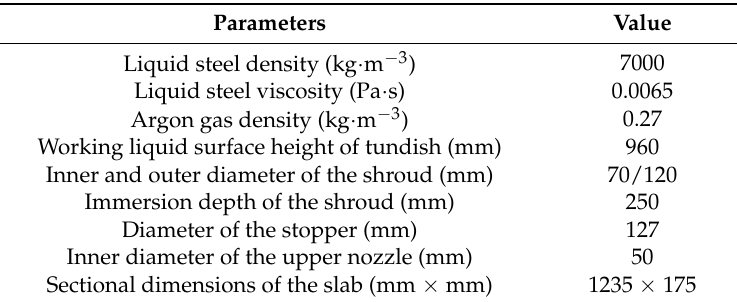
Table 1. Physical properties and process parameters.